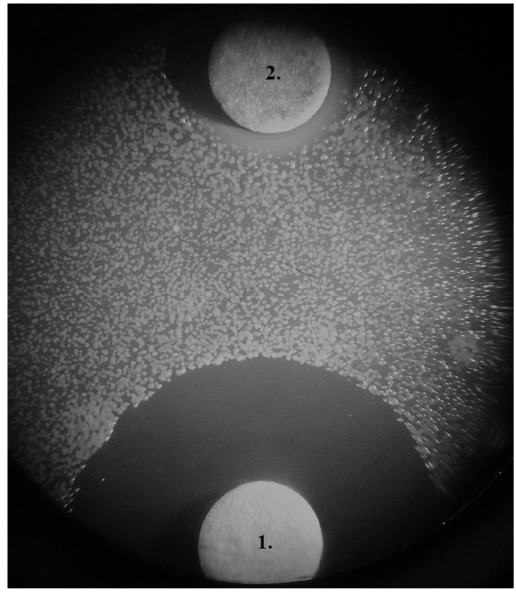
Figure 5. In vitro inhibitory zones on Brucella-agar. Fusobacterium nucleatum ATCC 25586 (100 µL McFarland 2); disc 1. 10µl (0.2%) chlorhexidine (18 mm), disc 2. 100 µL Lingora ® (8 mm).